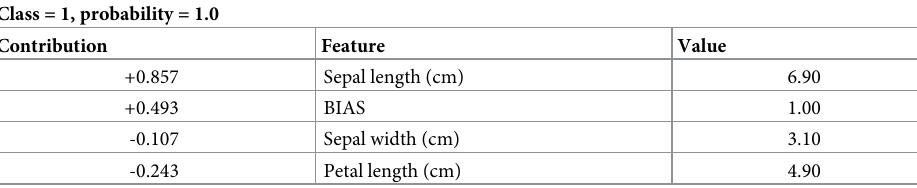
Table 1. Sample prediction and feature contribution